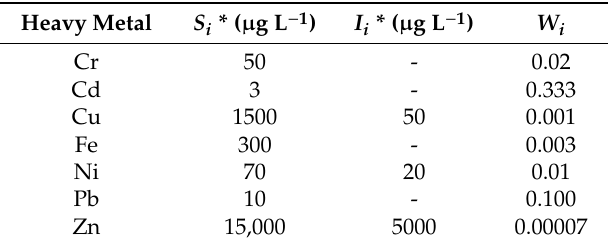
Table 3. The values of coe ffi cients ( S i , I i , guideline value, and W i ) used in HPI